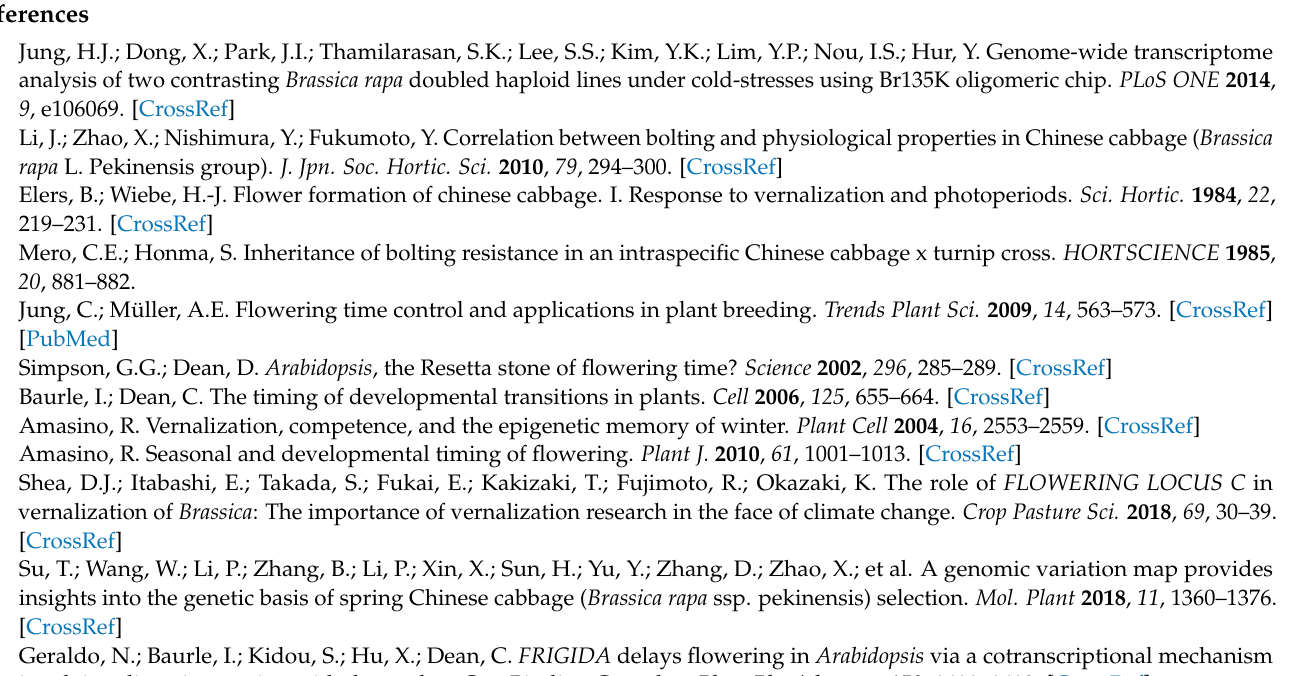
sequencing. Figure S3. The confirmation of the presence of hygromycin resistant gene ( hph ) and Cas9 transgenes using genomic PCR analysis in T 1 transgenic lines. Figure S4. The confirmation of the presence of Cas9 transgenes using genomic PCR analysis in ‘transgene-free’ BrVRN1 mutant GE2 lines. Figure S5. Genome-editing analysis of T 0 lines by deep-sequencing. Figure S6. Flowering- time phenotype in BrVRN1 mutant GE1 plants. Figure S7. Target gene mutations by the multiplex CRISPR/Cas9 system in the GE2 generation. Figure S8. Expression patterns of BrVRN1a in ‘transgene- free’ BrVRN1 mutant GE2 lines. Table S1. Features of BrVRN1 genes used in this study. Table S2. Summary of Brassica rapa L. (v3.0) reference genome. Table S3. Statistics of target four-gRNA position on the reference v3 genome. Table S4. CRISPR/Cas9-mediated targeted mutagenesis of BrVRN1 in the T 0 generation. Table S5. Statistics of final trimmed whole genome resequencing data from ‘transgene-free’ BrVRN1 mutant GE2